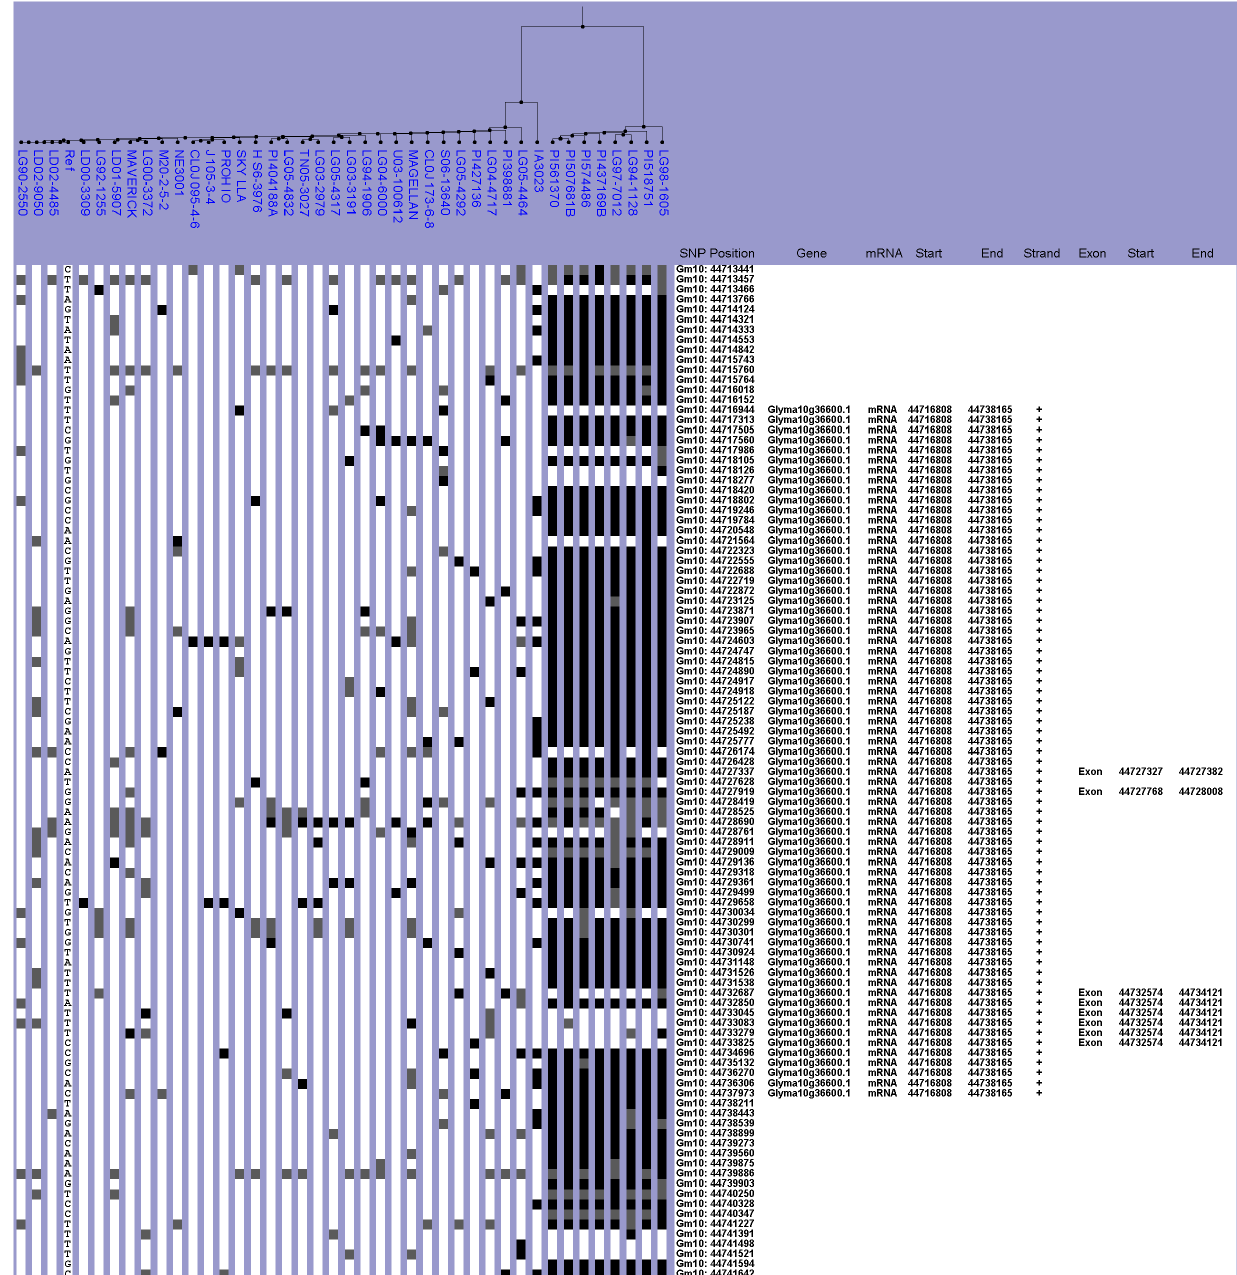
(Figure S6). The two NAM parent lines that were not in the Williams 82-like haplogroup (PI507681B and LG05-43170) formed a distinct subgroup when the two datasets were combined.